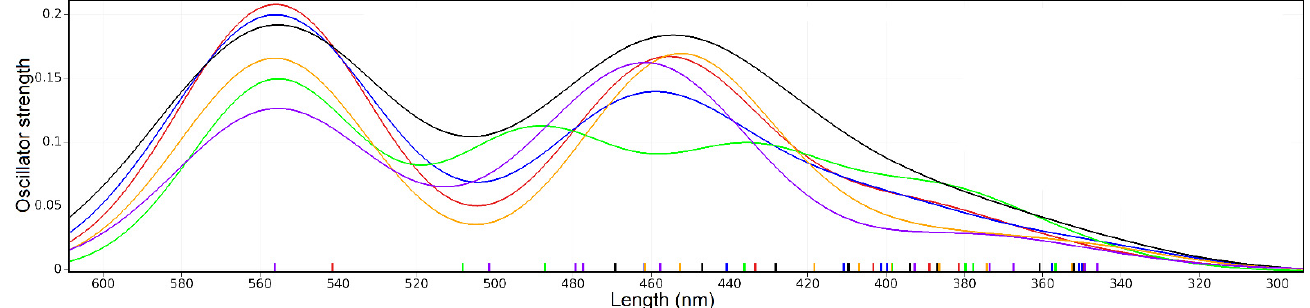
Figure 11. Theoretical excitation spectra for fagopyrin F conformers. Structure 31—red, 32—blue, 33—black, 34—green, 35—orange, and 36—purple. Table 4. The electron transition contribution and orbitals for fagopyrin F conformers.